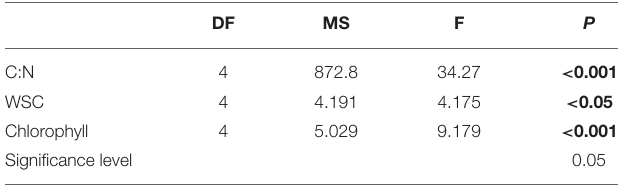
TABLE 3 | Results of one-way ANOVA testing effects of light manipulation on the physiological parameters C:N, water soluble carbohydrate content of rhizomes (WSC), and leave chlorophyll content.